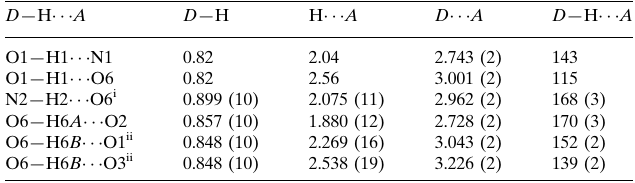
Hydrogen-bond geometry (A˚ , (cid:2)